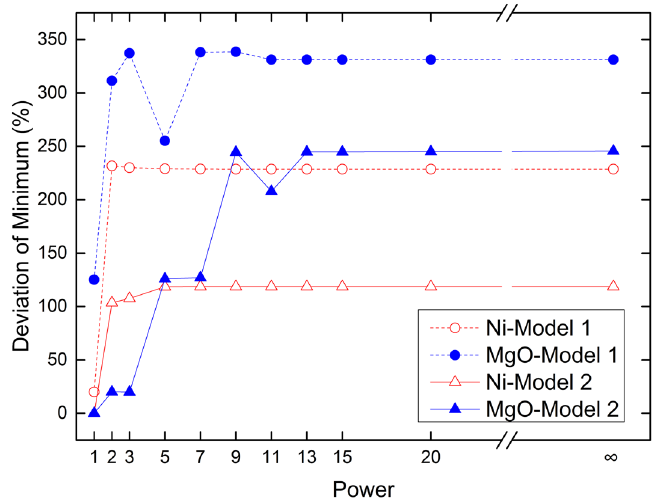
Figure 5. Deviation of minimum ore grade.